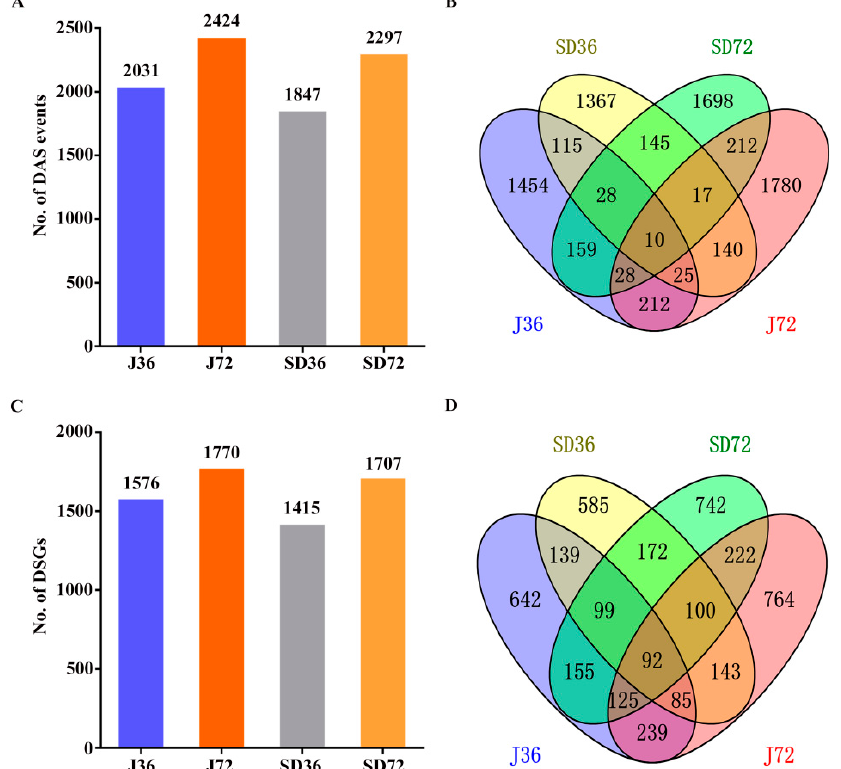
Figure 4. Identification and comparison analysis of DAS events and DSGs in response to A. alternata AP infection in apples. ( A ) The number of DAS events in response to A. alternata AP infection in apples. ( B ) Venn diagram showing the comparison of DAS events in response to A. alternata AP infection in apples. ( C ) The number of DSGs in response to A. alternata AP infection in apples. ( D ) Venn diagram showing the comparison of DSGs in response to A. alternata AP infection in apples. Correspondingly, a total of 4303 DSGs were characterized, including 1576 in J36, 1770 in J72, 1415 in SD36 and 1707 in SD72, respectively. Venn diagram showed that 642, 764, 585 and 742 DSGs were specific in J36, J72, SD36 and SD72, respectively, whereas